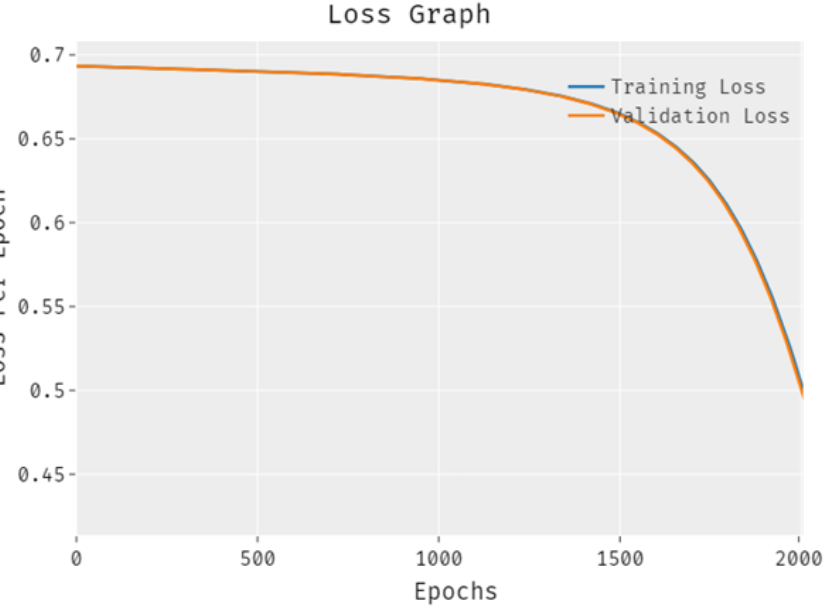
Figure 10. Loss analysis of ESOML-IDS technique under 2000